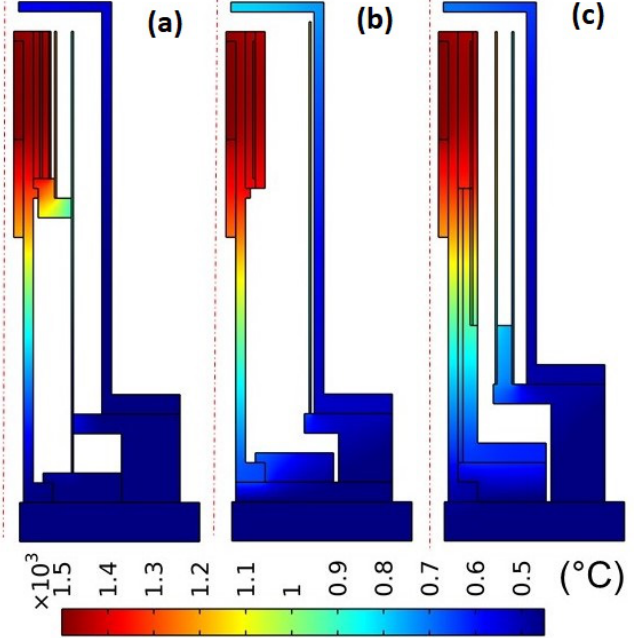
Figure 5. Temperature distribution: ( a ) First conventional cathode design; ( b ) Second conventional cathode design; ( c ) Coaxial-heater cathode